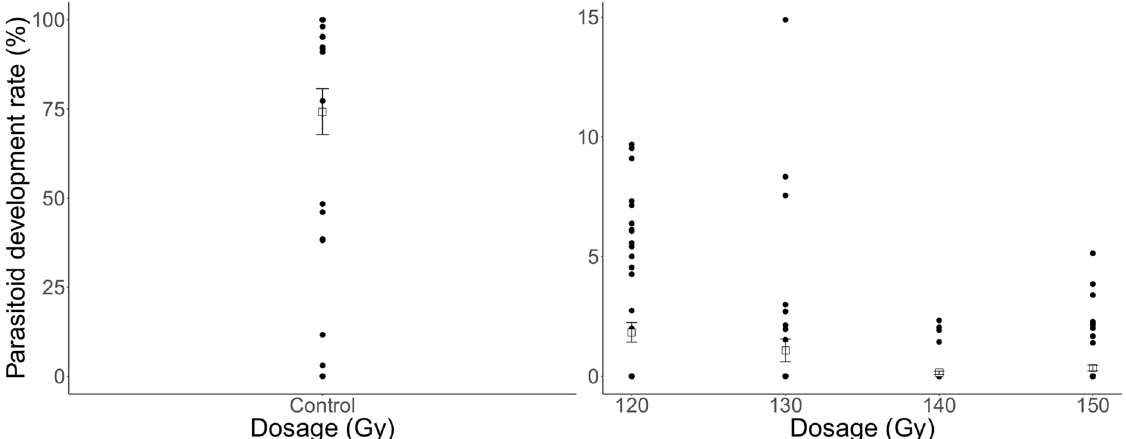
Figure 1. Lifetime percentage of Nezara viridula eggs attacked by irradiated and non-irradiated female Trissolcus basalis , which resulted in developed offspring of the latter. Squares and error bars represent means and standard error, respectively.